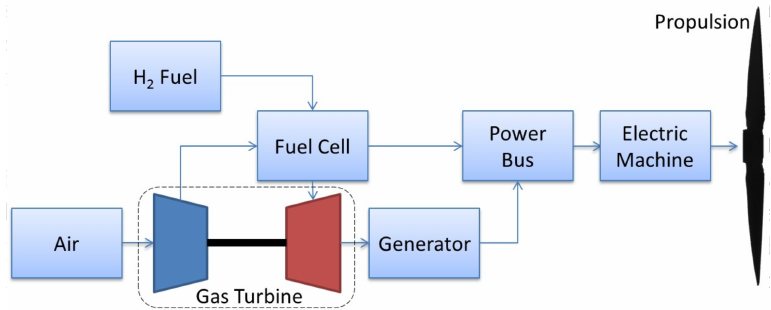
Figure 9. A fuel-cell and gas turbine hybrid system. In this example, both the fuel cell and gas turbine are generating electricity which is then used to power an electrically driven